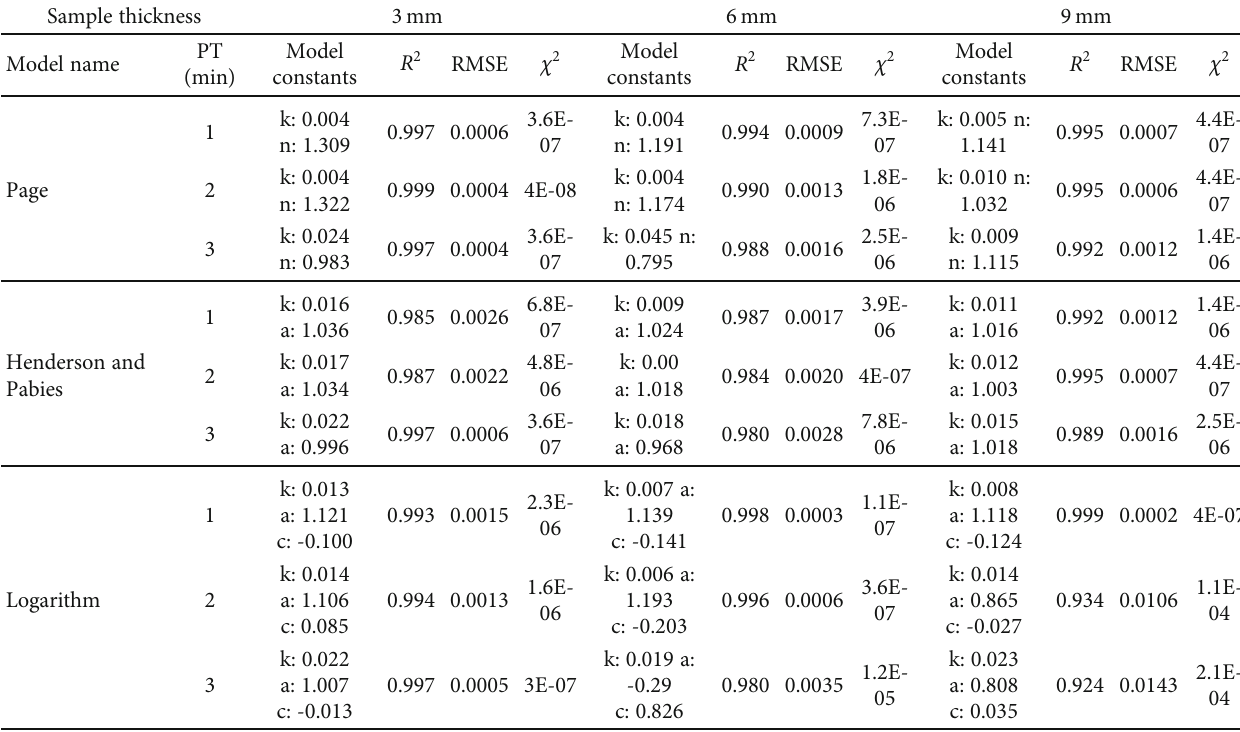
Table 4: Parameters and statistical results for the various drying models for blanch-assisted drying at 70 ° C. Sample thickness 3